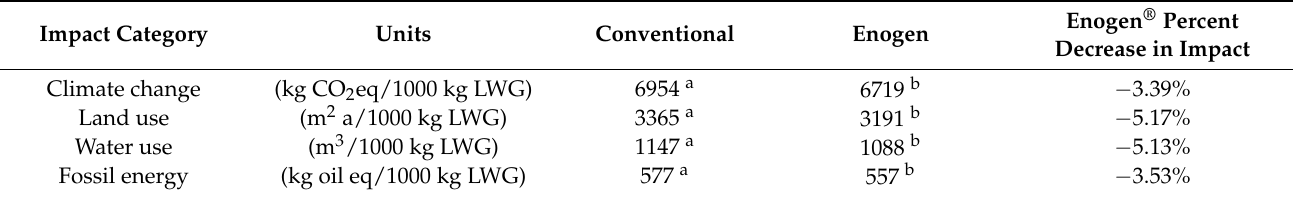
Table 3. Scenario 2: Environmental impacts and improvements for full gate-to-gate KSU backgrounding trial. Impact